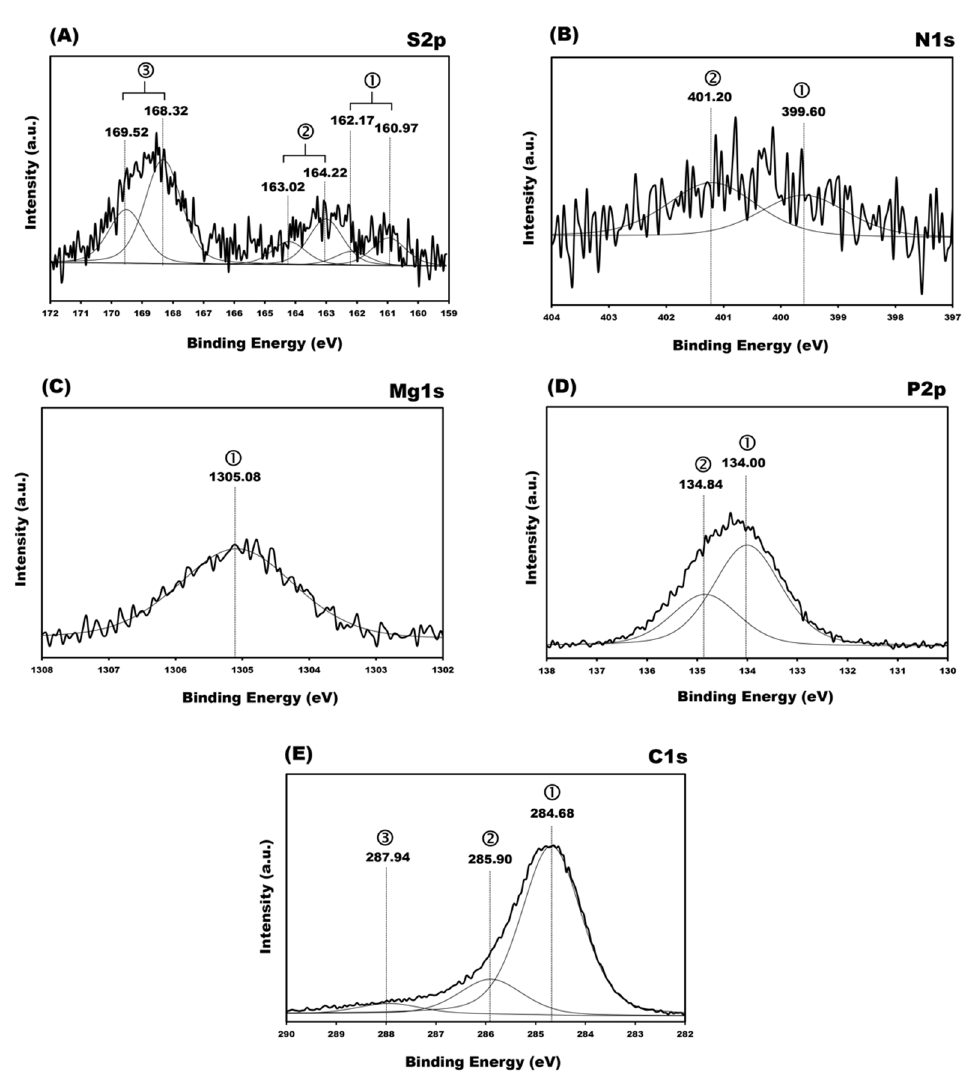
Figure 5. High-resolution XPS spectra of L-cysteine/ssDNA hybridize to the target sequence of LAMP amplification products on Au electrode. ( A ) S2p, ( B ) N1s, ( C ) Mg1s, ( D ) P2p and ( E ) Table 1. Peak fit parameters for five major elements on the absorbed layer in the ssDNA that hybridized the targeted LAMP amplification products and L-cysteine.